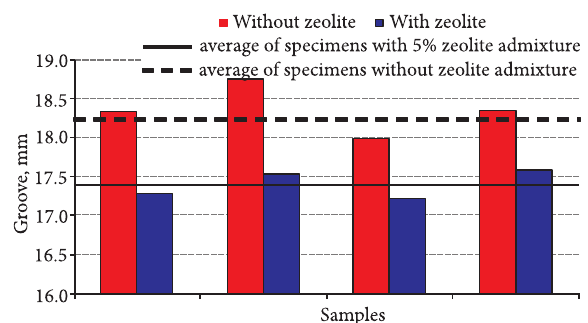
Fig. 6. Abrasion resistance of paving blocks after 28 days